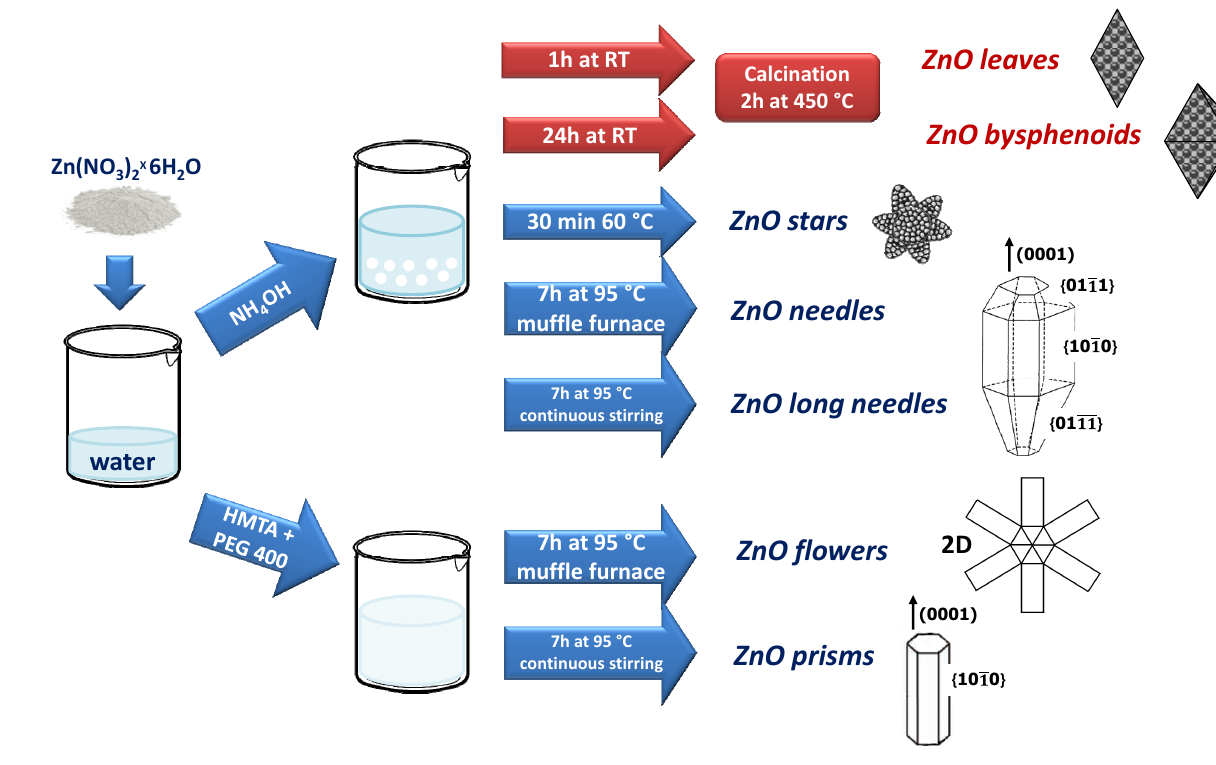
Figure 1. Schematic representation of the synthesis procedures. Leaves and Bisphenoids were synthesized starting from a 0.05 M water solution of Zn(NO 3 ) 2 × 6H 2 O. Water diluted ammonium hydroxide (28%, Carlo Erba Reagents) was